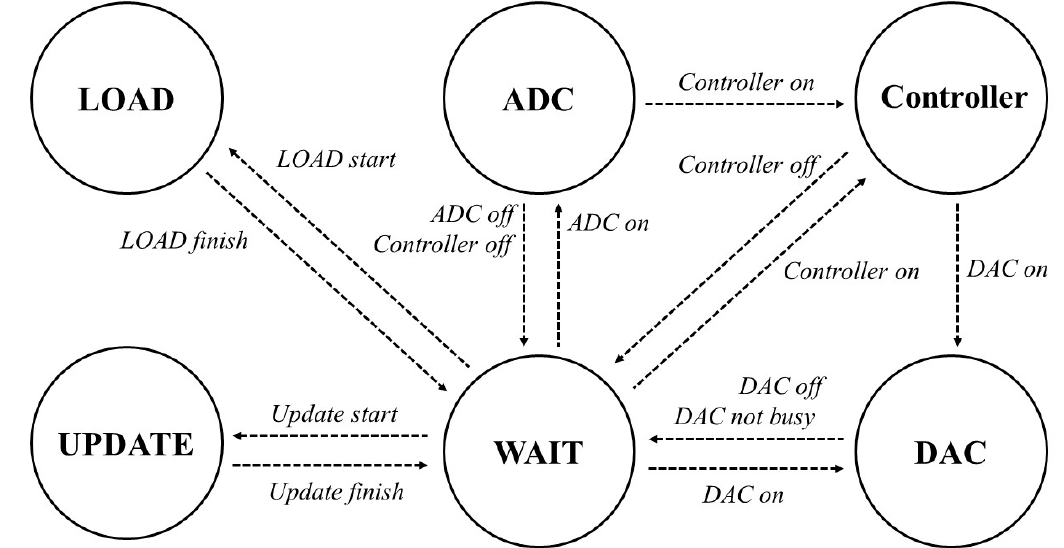
Figure 4. A diagram of the finite-state machine of the FPGA-based feedback controller.